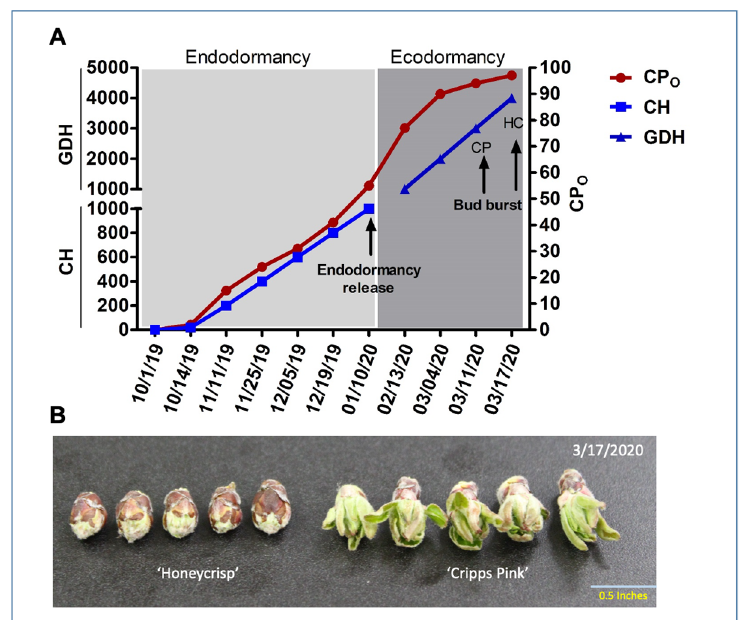
Figure 1. Accumulation of chilling hours (CH), chilling portions (CP O ), and growing degree hours (GDH) in ‘Honeycrisp’ (HC) and ‘Cripps Pink’ (CP). Accumulation of CH, GDH, CPO, and major events are shown with arrows ( A ). An image showing HC and CP flower buds collected on the same day ( B ). The CH accumulation started on October 2019 reaching 20 CH (2 CPO) on 10/14/2019.